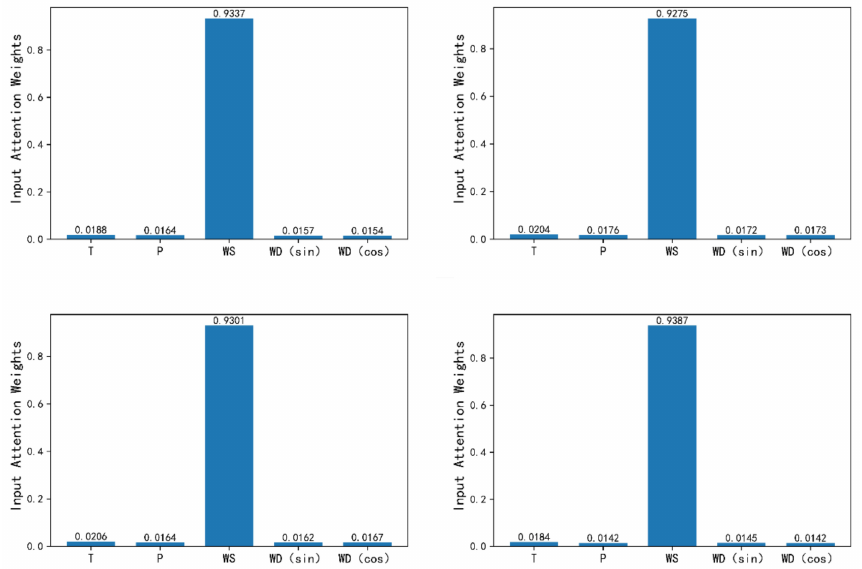
Figure 12. Input Attention Weights; T: Temperature; P: Pressure; WS: Wind Speed; WD(sin): Wind Direction sine; WD(cos): Wind Direction cosine.